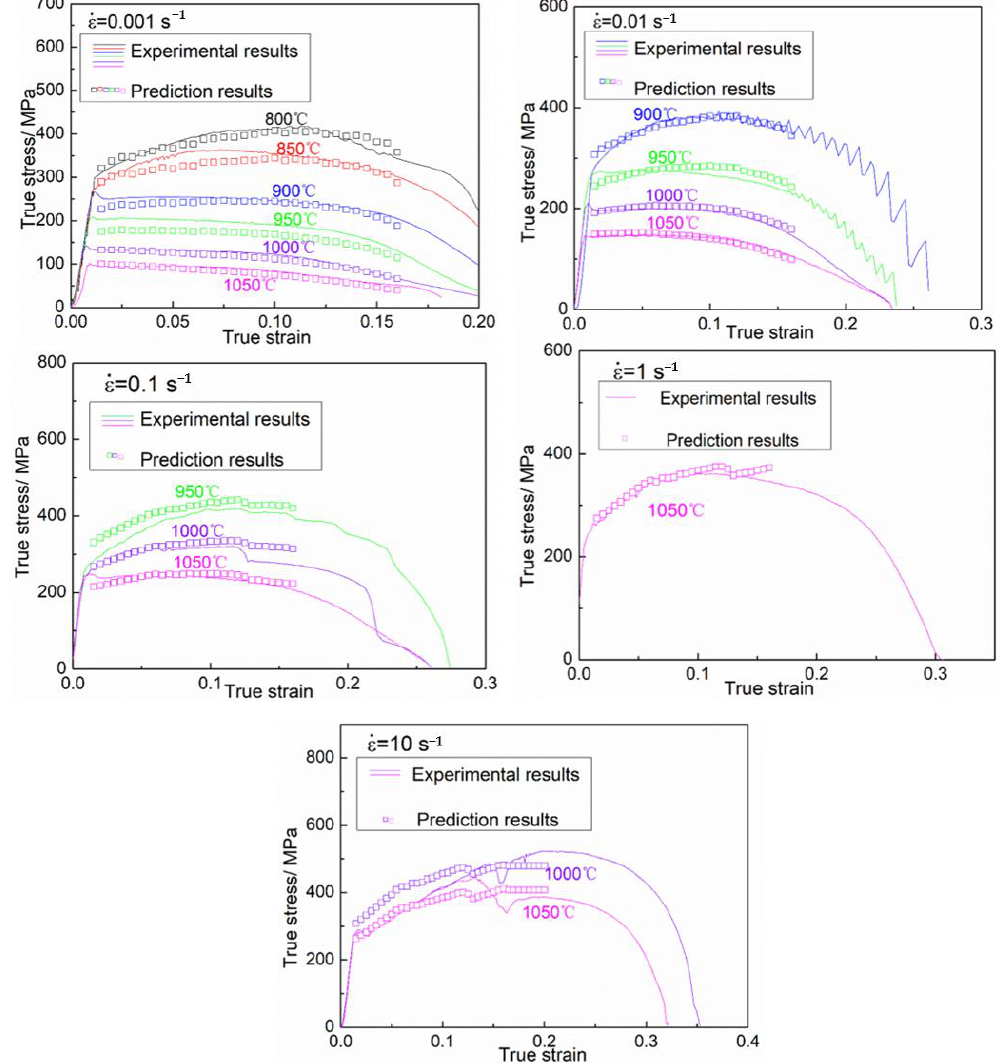
Figure 16. The prediction results of DRX, DRV and TDRV types by R-MAM.